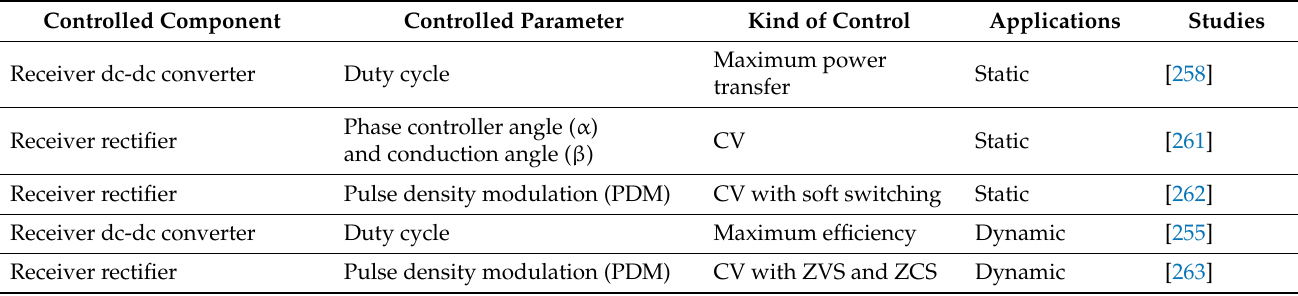
Table 12. Various receiver-side control